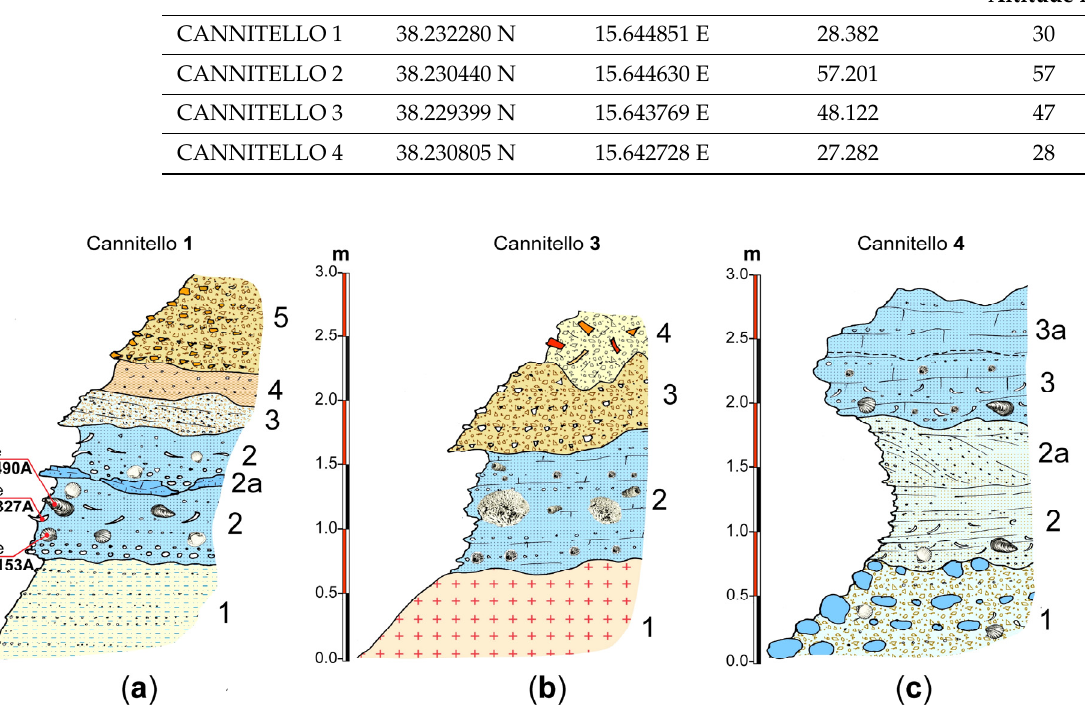
Figure 4. ( a – c ) Stratigraphic sections of the sites Cannitello 1, 3, and 4. For Cannitello 1, we have highlighted the position of the sampled and dated fossils of Table 2.